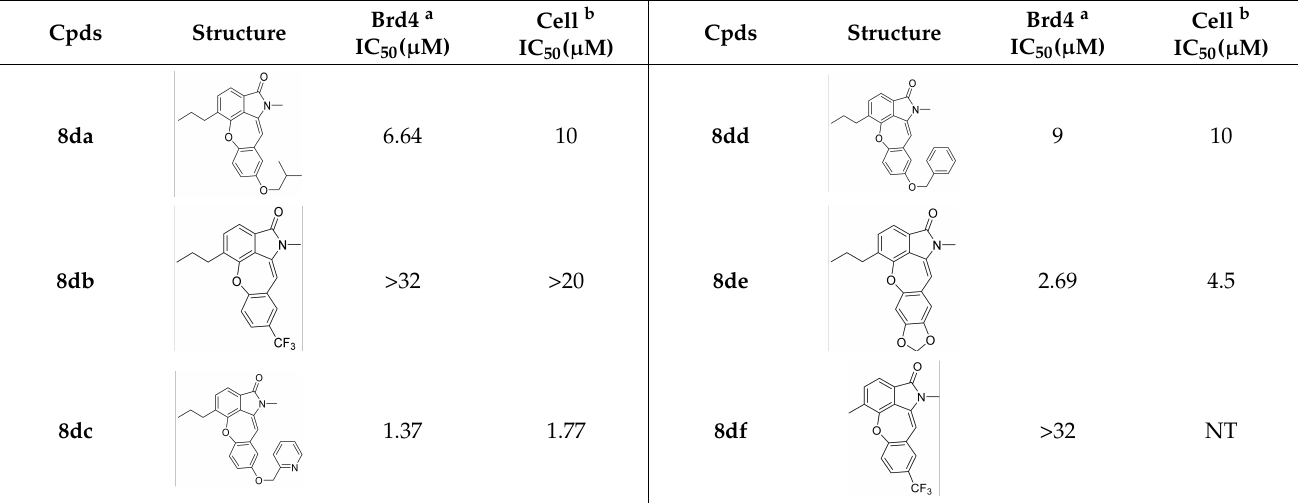
b To measure the Ty82 cell cytotoxic activity of compounds, MTS assay was performed. The CC 50 in the table was calculated with Prism6 program. Table 4. Inhibition effects of compounds fixed with alkyl chain at R 1 position.